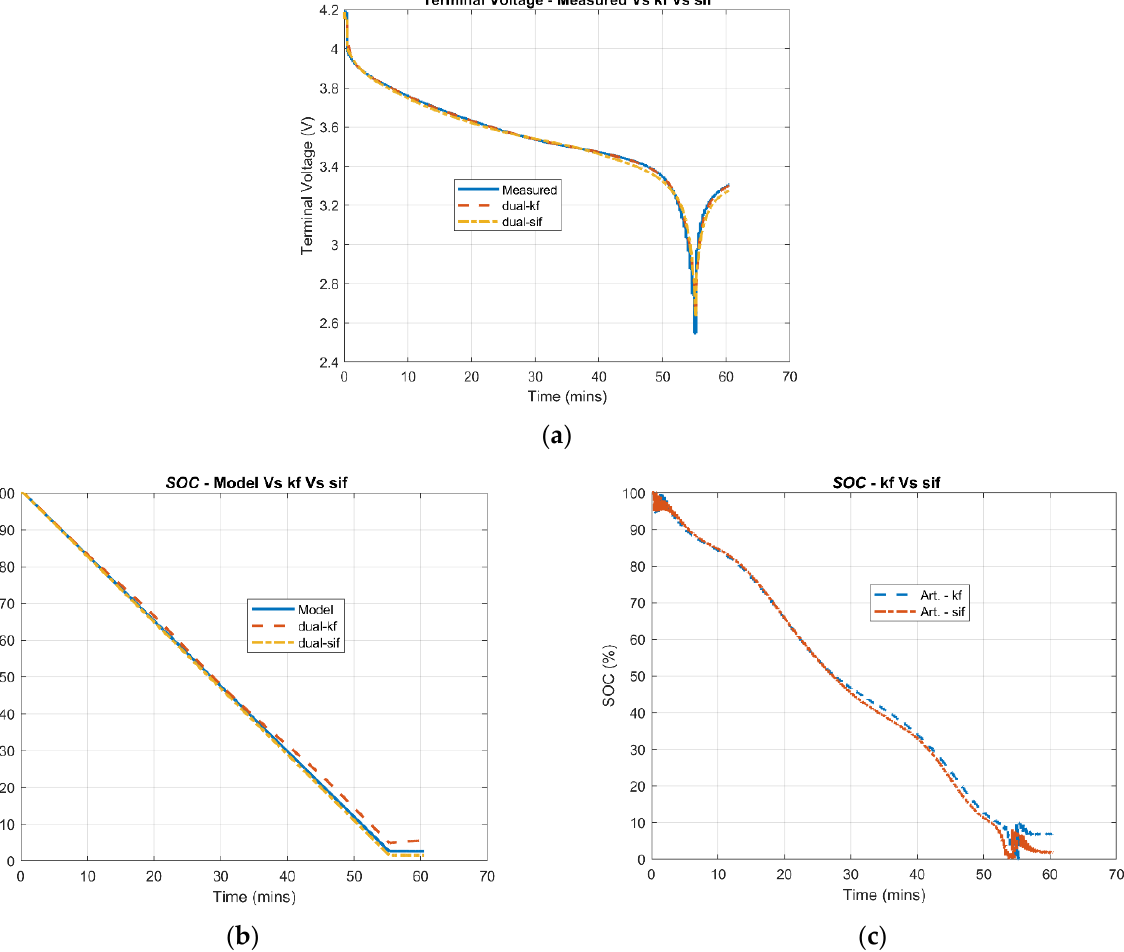
Figure 7. 10th Cycle Results: ( a ) Terminal Voltage, ( b ) SOC Estimate, ( c ) SOC Artificial Measure- ment.